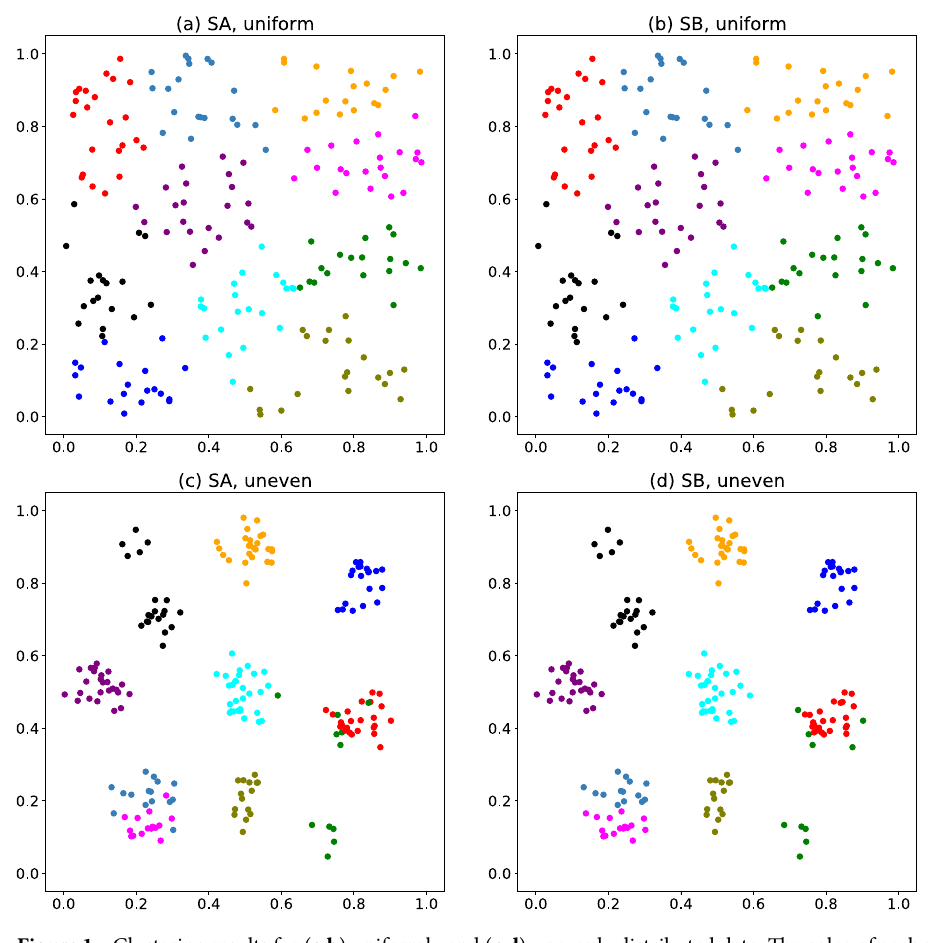
Figure 1. Clustering results for ( a , b ) uniformly and ( c , d ) unevenly distributed data. The color of each point represents its group. ( a , c ) were obtained using SA, whereas ( b , d ) were obtained using SB.